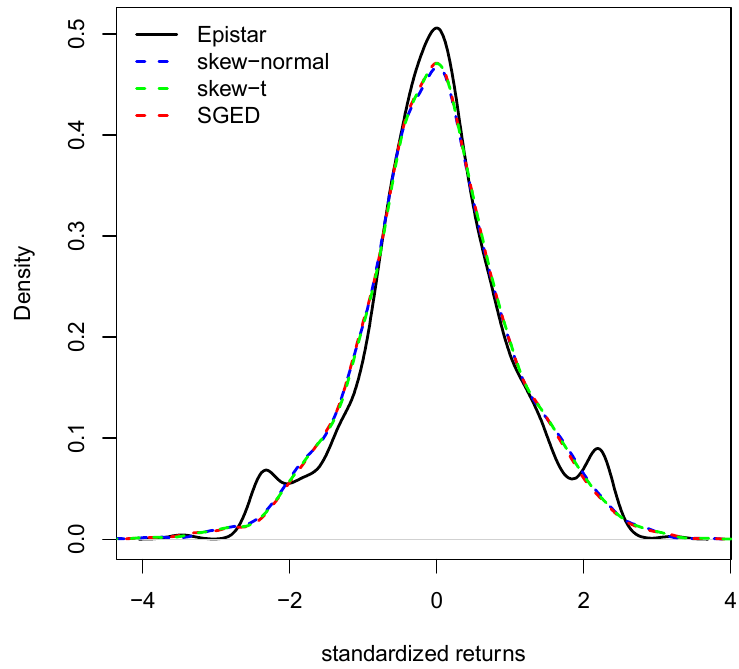
Figure 3. Epistar’s standardized returns and standardized residuals of the AR(1)-GARCH(1,1) model under the skew-normal, skew-t and SGED distributions.